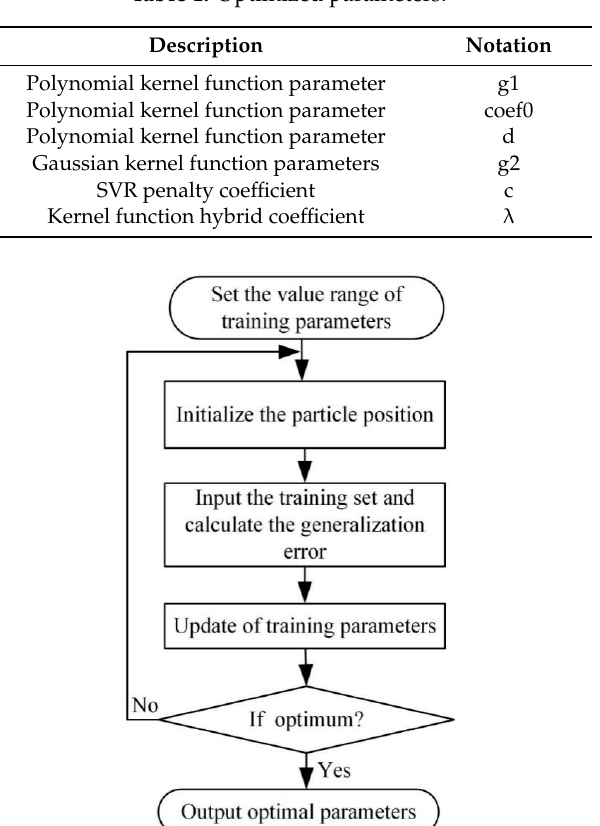
Table 1. Optimized parameters.